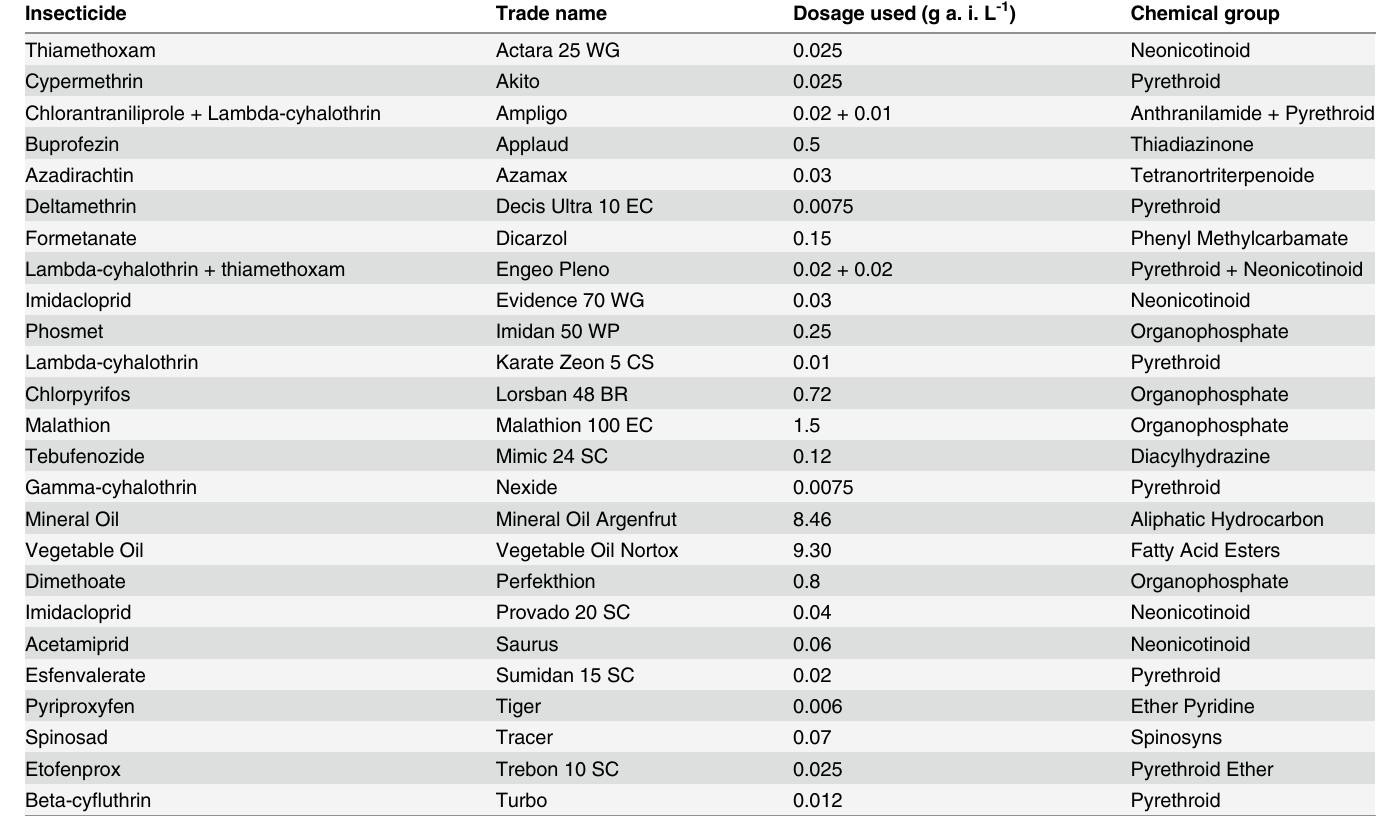
Table 1. Insecticides used in bioassays, with their concentrations and chemical